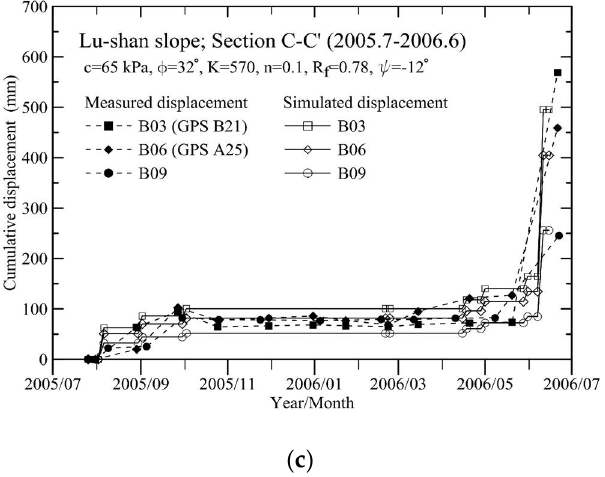
Figure 20. Comparison between measured slope displacements and those calculated using ( a ) c = 65 kPa, ϕ = 3 2 ◦ , K = 260, n = 0.1, R f = 0.75 and Ψ = − 12 ◦ ; ( b ) c = 65 kPa, ϕ = 32 ◦ , K = 200, n = 0.25, R f = 0.75 and Ψ = − 12 ◦ ; ( c ) c = 65 kPa, ϕ = 32 ◦ , K = 570, n = 0.1, R f = 0.78 and Ψ = − 12 ◦ .